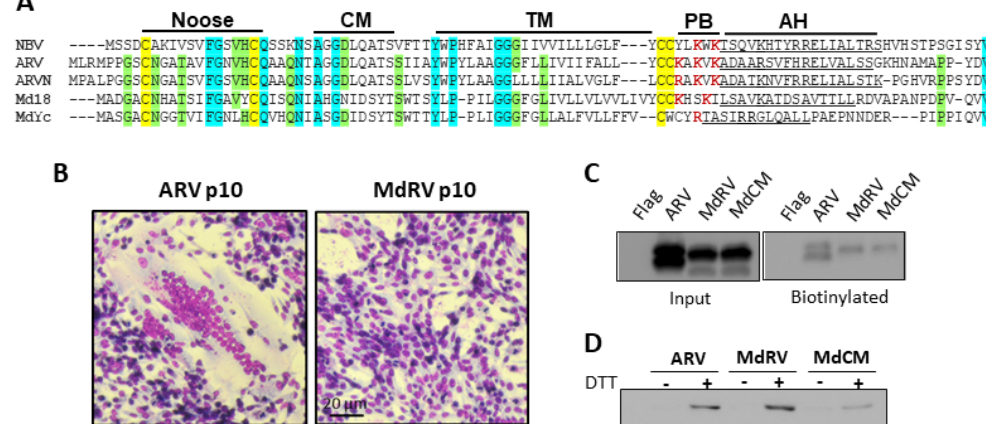
Figure 5. Novel MdRVp10 forms a cystine nose fusion peptide and traffics to the plasma membrane but is non-fusogenic. ( A ) Sequence alignments of the p10 FAST proteins encoded by the indicated fusogenic orthoreovirus species (Nelson Bay orthoreovirus (NBV), AF218360; ARV, AF218358; ARVN, AB914766) and two MdRVn isolates of ARV MdRVn-J18 (Md18, AFV52275) and MdRVn-Ych (MdYc, QEQ13297). The indicated hallmark p10 features are labeled as in Figure 3. The conserved cysteine residues are highlighted in yellow, completely conserved amino acids are highlighted in cyan, and residues conserved in four of five alignments are shaded green. Basic amino acids within the PB motif are in red boldface. ( B ) Transfected QM5 cells expressing ARV or MdRV p10 were fixed and Giemsa stained at 48h post-transfection to detect syncytium formation by bright field microscopy at 100x magnification. ( C ) QM5 cells expressing N-terminally FLAG-tagged versions of the indicated p10